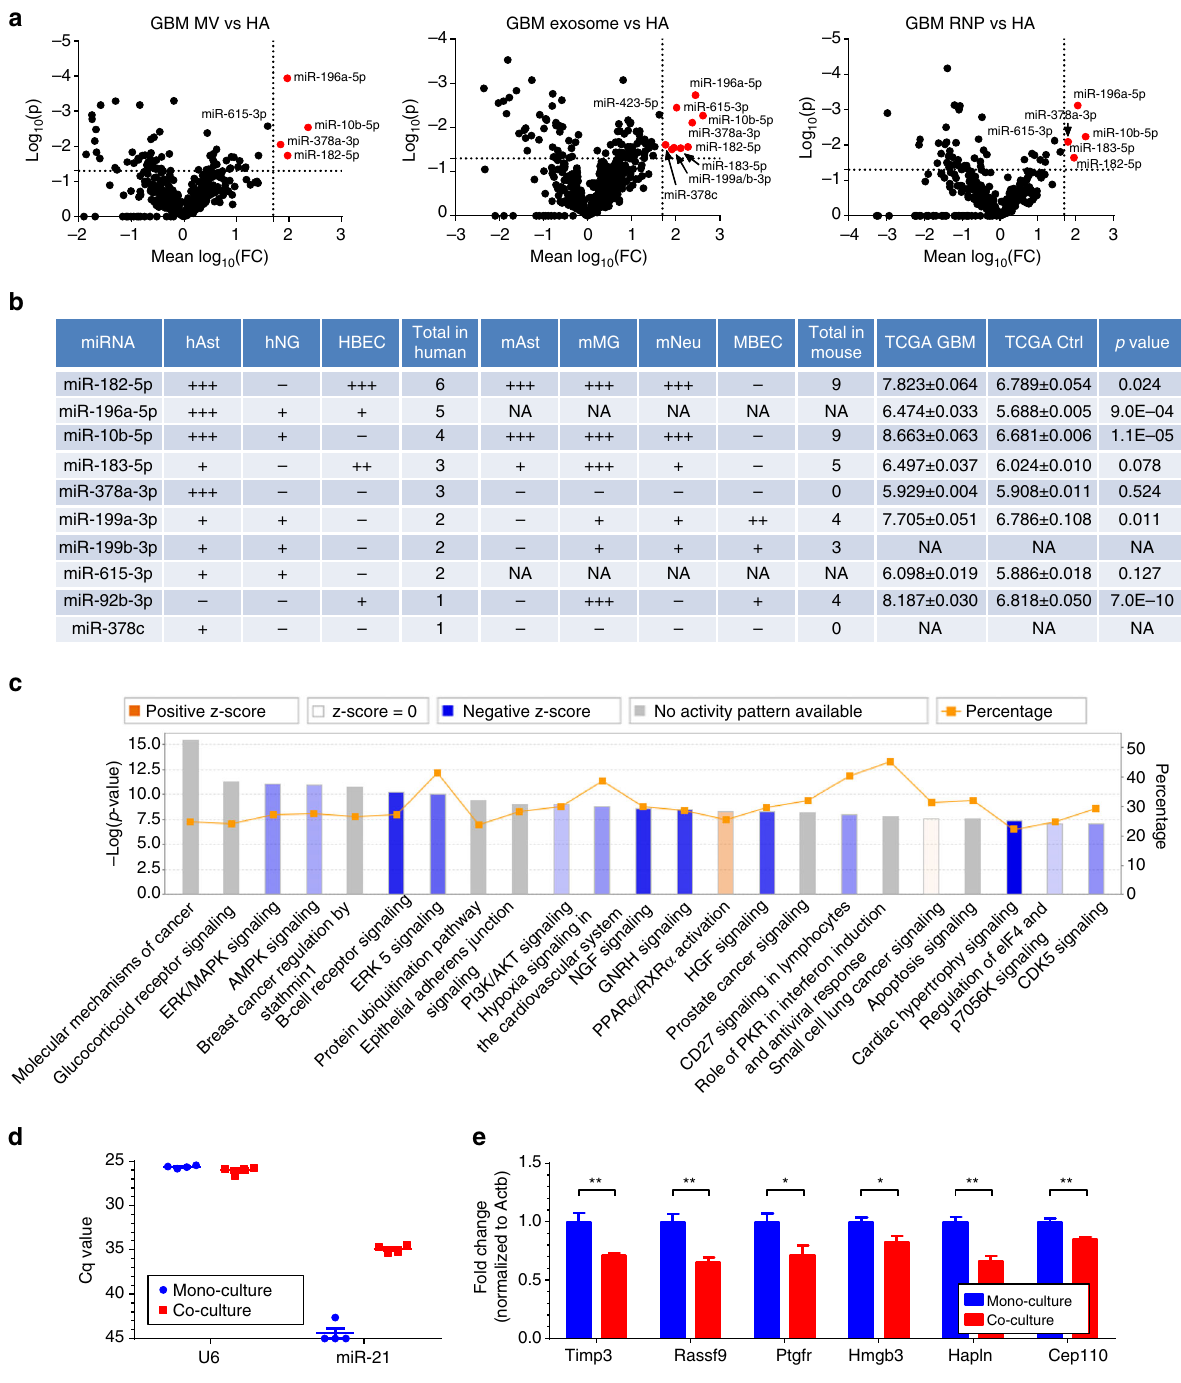
Fig. 8 Comparative analysis of GSC-secreted miRNAs and cellular miRNome of the normal cells of the brain predicts the most impactful GBM miRNAs in tumor-to-microenvironment communication. a Extracellular fractions of GSC cultures were compared to primary human astrocytes (HA), based on the corresponding RNAseq data sets. The fold-changes in miRNA levels were log transformed and a t -test was applied to examine the signi fi cance of difference. MiRNAs with log-fold changes higher than 1.7, which corresponded to 50 times higher levels in the GSC-derived exRNA fractions relative to the recipient cells, and p < 0.05 ( t -test), were de fi ned as potentially impactful (colored in red). The horizontal axis of Volcano plots shows the log-fold difference, and the vertical axis shows the statistical signi fi cance. Similar analyses of primary human neuroglial and endothelial cells are shown in Supplementary Fig. 18. b A full list of most impactful GSC miRNAs for human and mouse astrocytes, neurons, microglia, or brain endothelial cells. The number of “ + ” symbols re fl ects the number of extracellular fractions in which an miRNA meets the indicated criteria as in a . Most of these miRNAs are also upregulated in the GBM tumors compared to non-neoplastic brain tissues in the TCGA microarray data set, as indicated in the three right columns ( n = 496 GBM vs 10 control). c Top enriched IPA pathways for the validated mRNA targets of the most impactful miRNAs. Predicted activation and inhibition of pathways are labeled as orange and blue bars, respectively. The yellow line shows the percent of genes in each pathway that are validated targets. d , e Co-cultured with GBM8 neurospheres, primary miR-21-null astrocytes exhibit steady miR-21 levels ( d ) and downregulation of validated miR-21 targets ( e ). Cq value of miR-21 in mono-cultures was de fi ned as 45 (undetectable expression). N = 4 wells in 24-well plate. All bars represent mean ± SEM. *, p < 0.05; **, p < 0.01; t